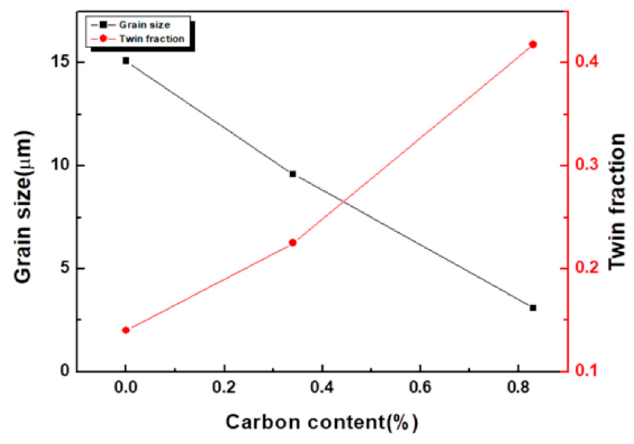
Figure 3. The change in grain size and annealing twin volume fraction as a function of carbon content.